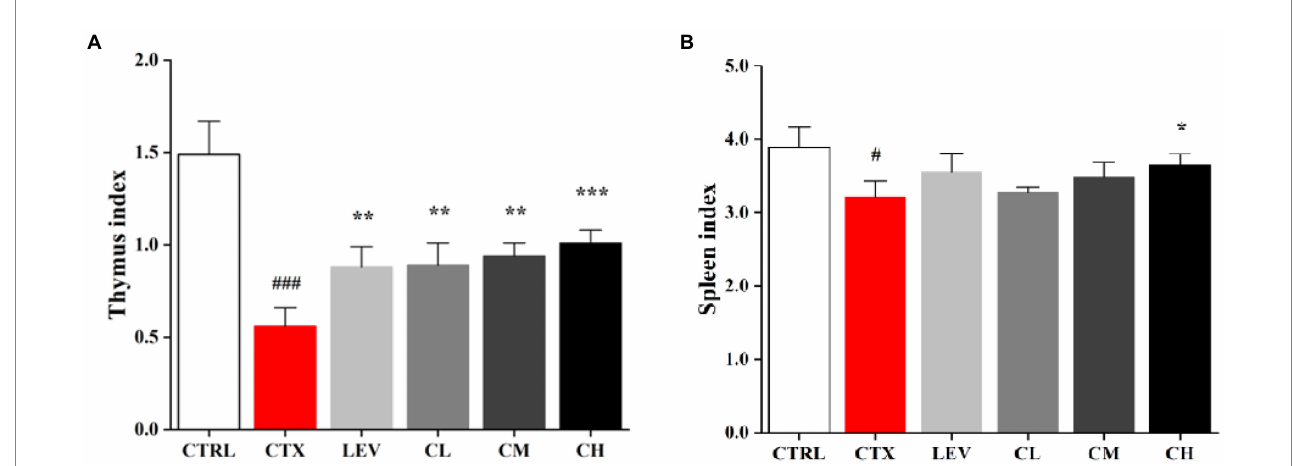
FIGURE 1 Complex probiotics adjusted immune organ indices in CTX-induced immunosuppression mice. (A) Thymus index. (B) Spleen index. CTRL, normal control group; CTX, model control group; LEV, levamisole hydrochloride; CL, low-dose complex probiotics; CM, Medium-dose complex probiotics; CH, high-dose complex probiotics. All data are expressed as mean ± SD. # p < 0.05, ## p < 0.01, ### p < 0.001 compared with CTRL; * p < 0.05, ** p < 0.01, *** p < 0.001 compared with